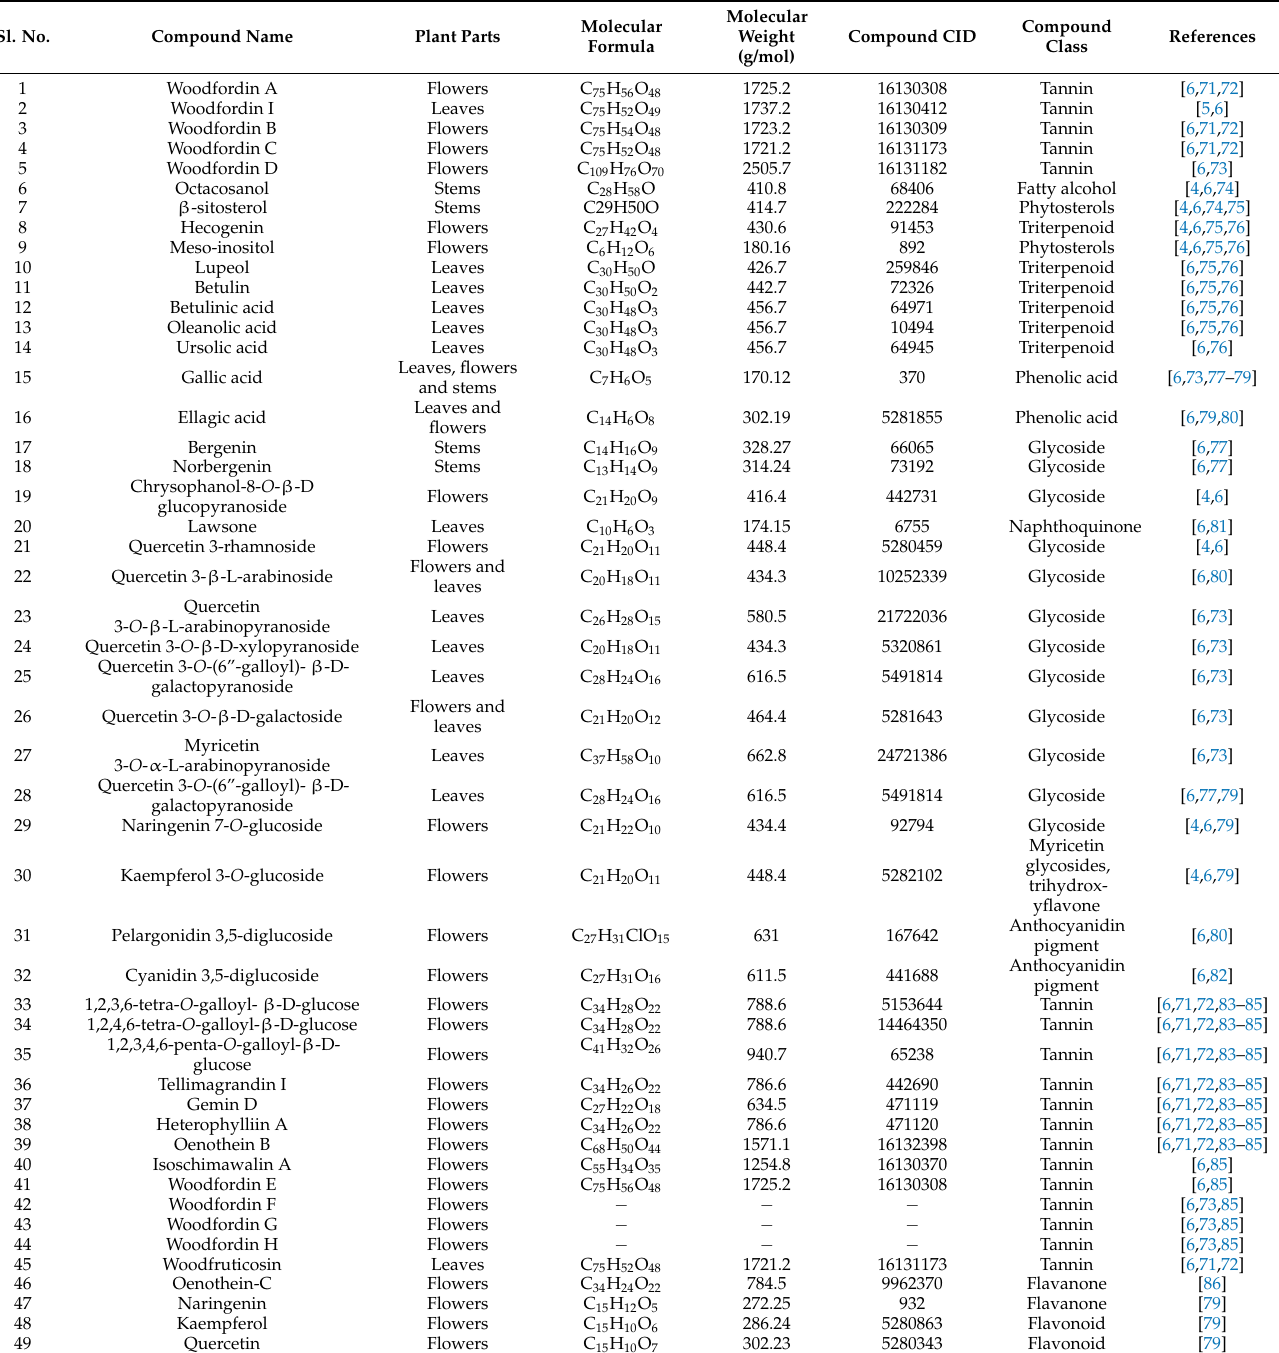
Table 1. Quantitative compounds retrieved from literature review of W.